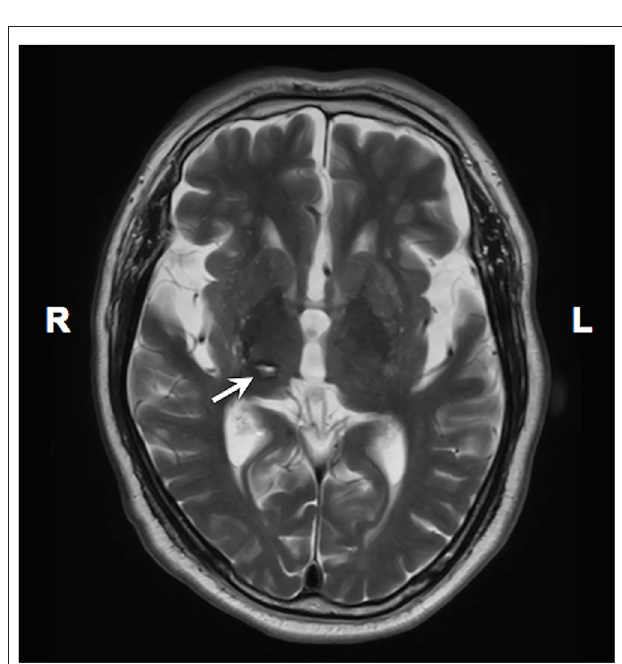
FIGURE 3 | A T2 weighted MRI image showing thalamic lesion in case 2 . An arrow indicates the stroke lesion in the right thalamus.